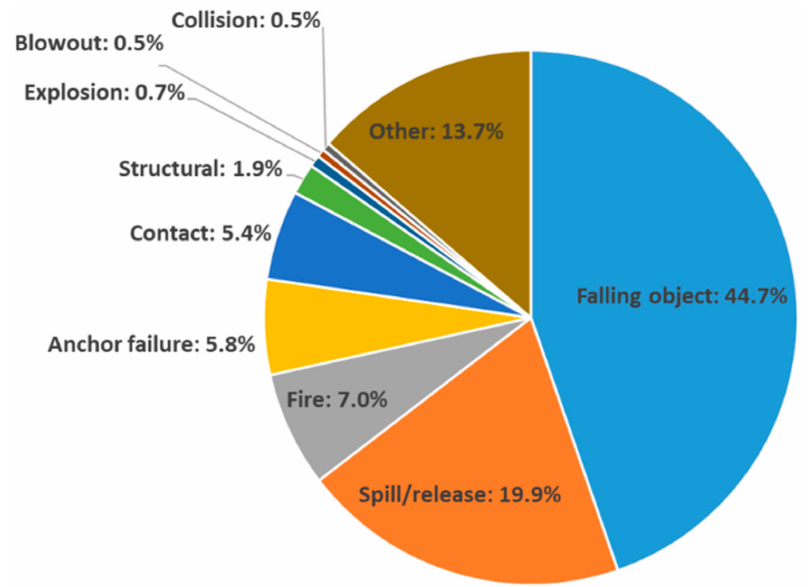
Figure 1. Statistics of marine floating structure accidents in the UK sea area from 1980 to